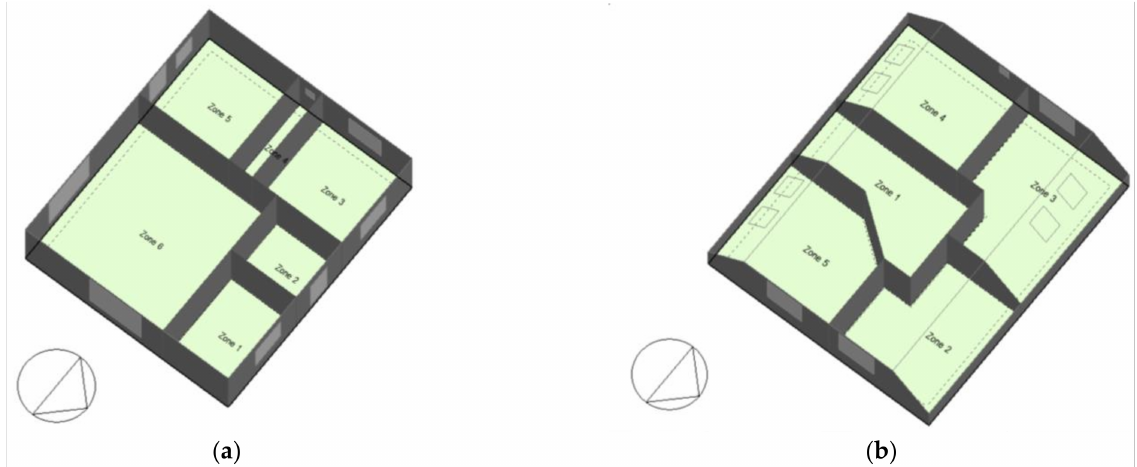
Figure 4. Model of division of the analyzed building into zones: ( a ) on the ground floor; ( b ) in the attic (own elaboration).